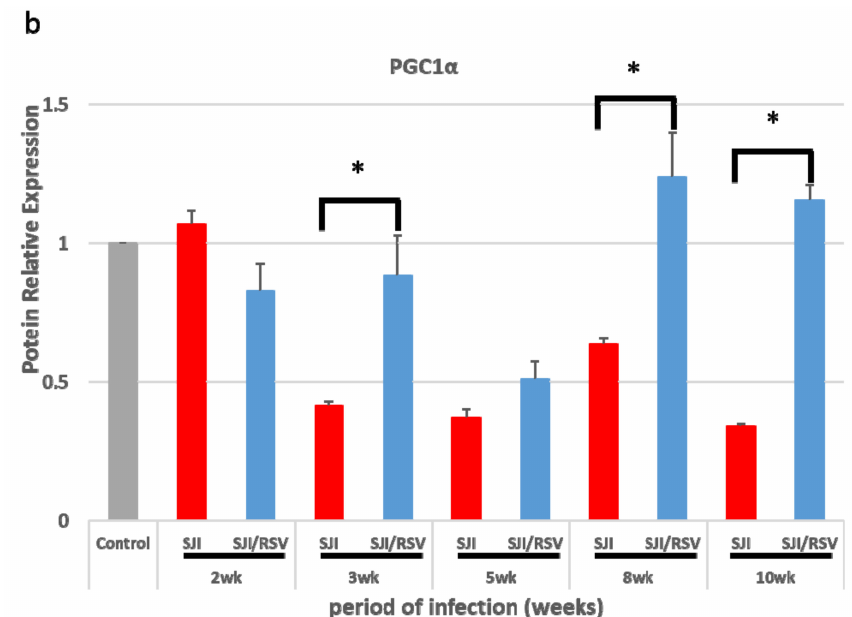
Figure 1. Resveratrol (RSV) increases peroxisomal proliferative activated receptor- γ coactivator 1 α (PGC-1 α ) expression associated with mitochondrial biogenesis in the liver tissue of S. japonicum -infected mice. ( a ) Representative images of western blot gels for PGC-1 α expression. ( b ) Quantitative changes measured by the ImageJ plugin software. RSV increased PGC-1 α expression compared with the non-treated group (uninfected mice were used as the normal control group). Results are presented as mean ± SD (n = 5). * p < 0.05, unpaired Student t test.